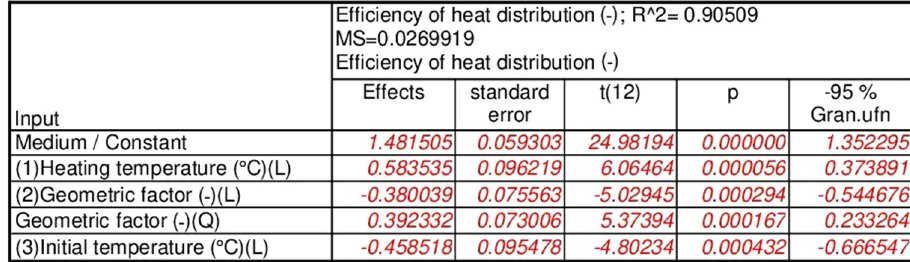
Figure 14. Results of the analysis of the effect of statistically significant input quantities on the response function value, applicable to the PCM/coke recyclate heat accumulator.